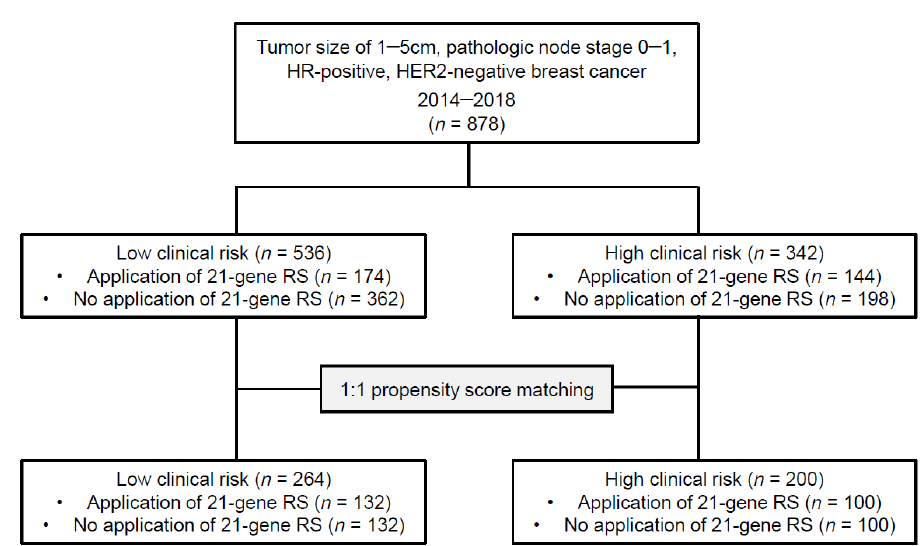
Figure 1. Study Figure 1. Study flowchart.